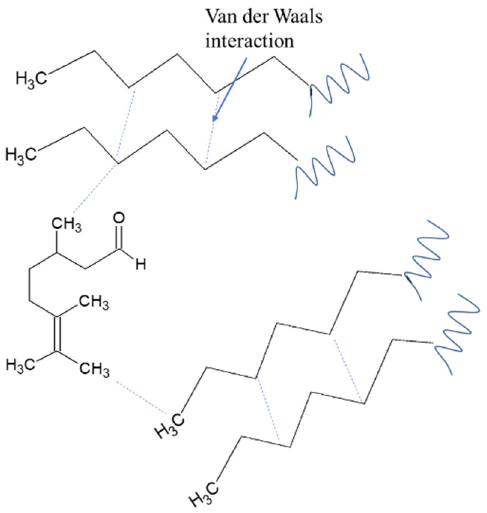
Figure 5. Hypothesis of diesel fuel interaction with FA (citronellal as main component) [9].